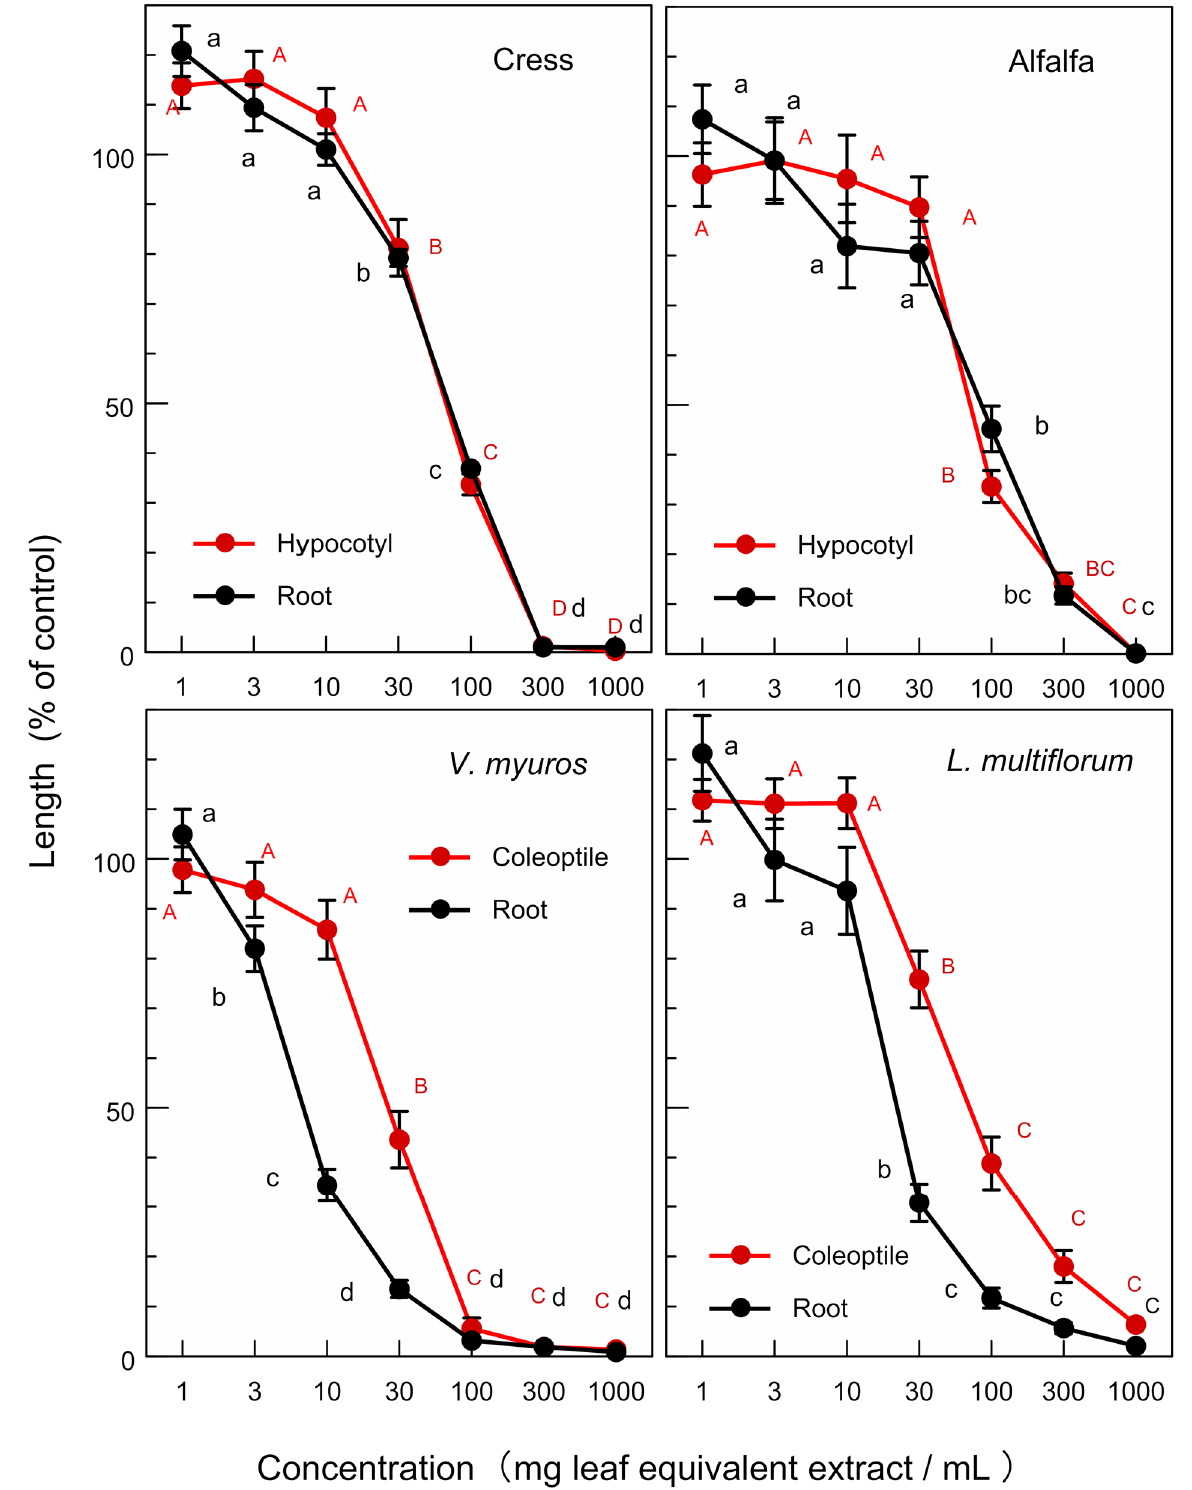
Figure 3. Effects of the extracts of O. fragrans leaves on the growth of the hypocotyls and roots of cress and alfalfa, and the growth of the coleoptiles and roots of L. multiflorum and V. myuros . Concentration (mg leaf equivalent extract/mL) indicates the concentration of the tested sample corresponding to the extracts obtained from 1, 3, 10, 30, 100, 300, and 1000 mg leaves per mL. Different letters on the symbols in the same panels indicate significant differences (Tukey’s HSD test, p ≤ 0.05).